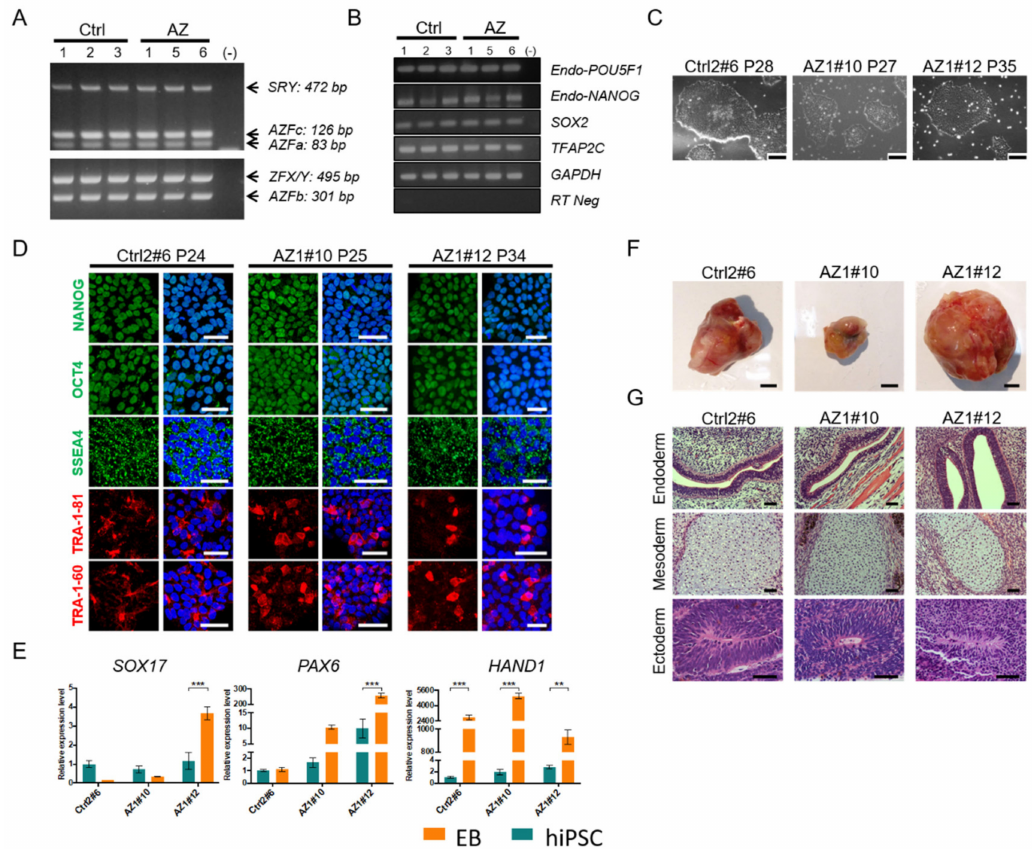
Figure 3. Characterization of the stem cell potency in AZ and control hiPSCs. ( A ) Detection of azoospermia factor (AZF) a, b, and c genes from the genomic DNA of whole blood of azoospermia (AZ1, 2, and 3) and control (Ctrl1, 2 and 3) patients. SRY represents the male specific gene, and ZFX/Y is used as the internal control. ( B ) Pluripotent genes including endogenous OCT4 , NAONOG , SOX2 , TFAP2C are reactivated in hiPSC lines from azoospermia patients (AZ1, 5, and 6) and control men (Ctrl1, 2, and 3). GAPDH indicates the internal control, and RT-Neg represents the template RNA without reverse transcription. ( − ) non template negative control. ( C ) Phase-contrast images of iPSCs derived from control (Ctrl) and 2 azoospermic (AZ) men. Scale bar: 200 µ m. ( D ) Immunofluorescence staining of pluripotency-related markers, NANAOG, OCT4, SSEA4, TRA-1-81, and TRA-1-60, in AZ-hiPSC (AZ1#10 and #12) and control (Ctrl2#6) lines. Merged images of pluripotent markers with cell nuclei counter stained with DAPI (blue color). Scale bar: 20 µ m. ( E ) Relative expression levels of germlayer specific genes ( SOX17 for endoderm, PAX6 for ectoderm, and HAND1 for mesoderm) in hiPSCs and 10-day EBs analyzed by real-time RT-PCR. Error bars indicate mean ± SEM from three replicates (two-way ANOVA, ** p < 0.01; *** p < 0.001). ( F ) Morphology of teratoma tissue in AZ-hiPSC lines (AZ1#10 and #12) and control hiPSCs (Ctrl2#6) collected from NOD/SCID mice. Scale bar: 5 mm. ( G ) Representative images of H&E-stained teratoma section from hiPSCs demonstrate the potency of three germ layers. Ciliated cells (endoderm), cartilage-like cells (mesoderm) and primitive neuronal cells (ectoderm) can be observed in all three hiPSC lines. Scale bar: 50 µ